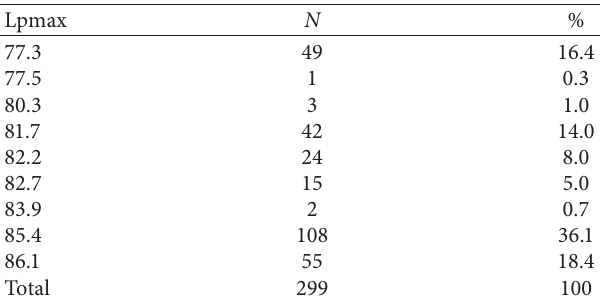
Figure 1: Background noise.